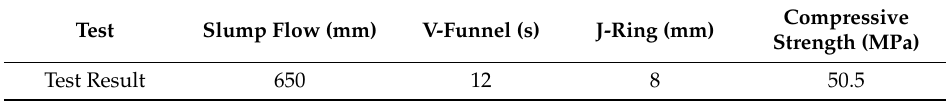
Table 1. Self-compacting concrete (SCC) material properties.